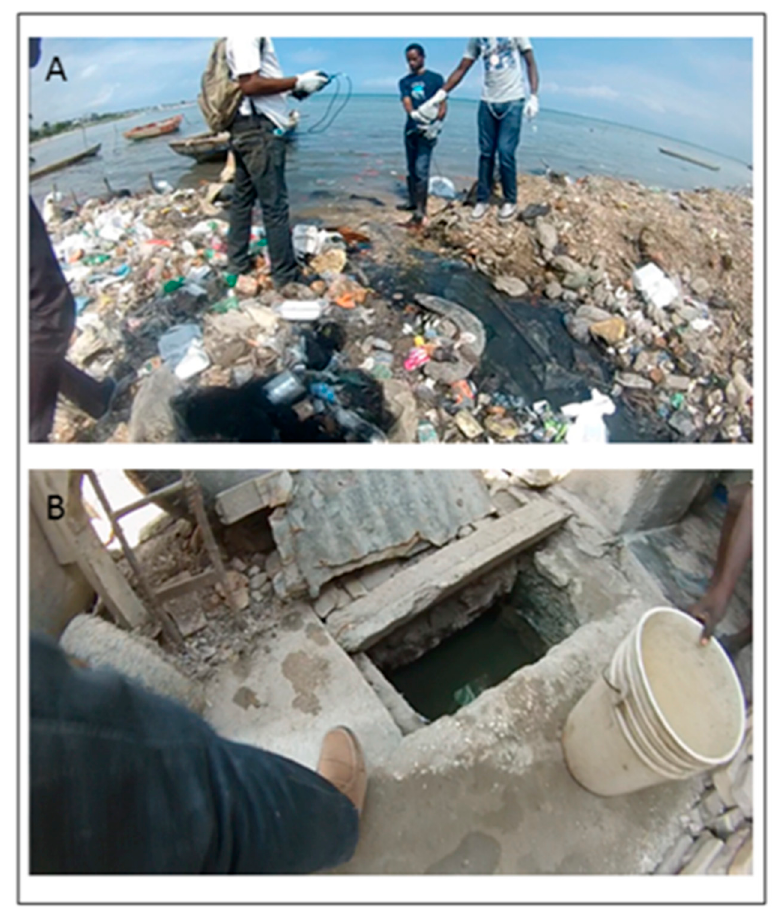
Figure 4. Two environmental testing locations used as a comparison with the household water point samples. ( A ) is an ocean site (EC 11) while ( B ) is a tidal water filled reservoir (EA 16).